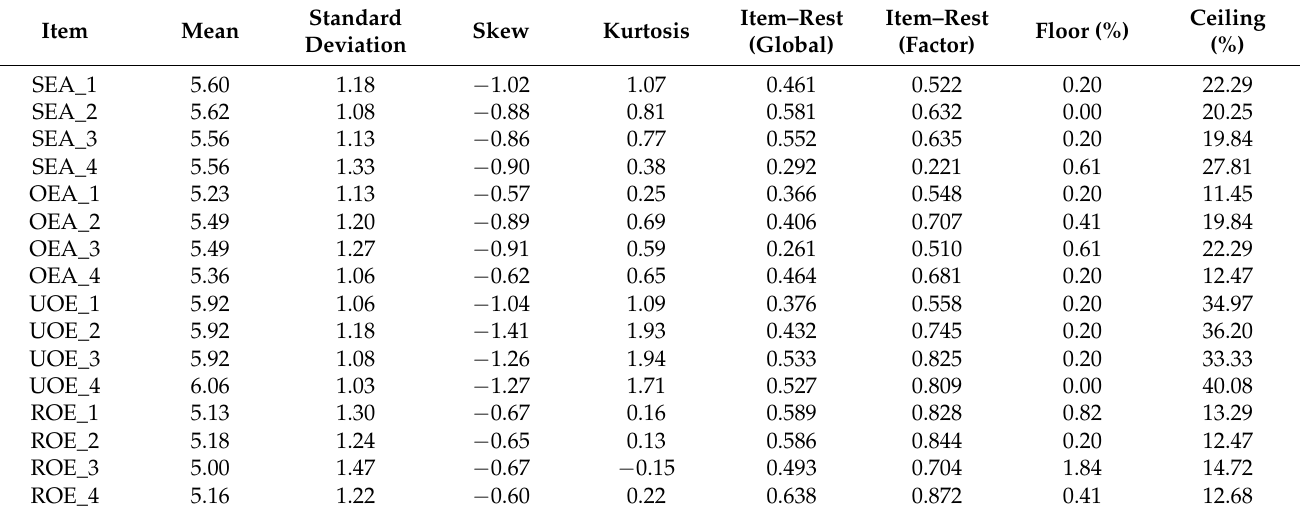
Table 2. Item analysis and discrimination.